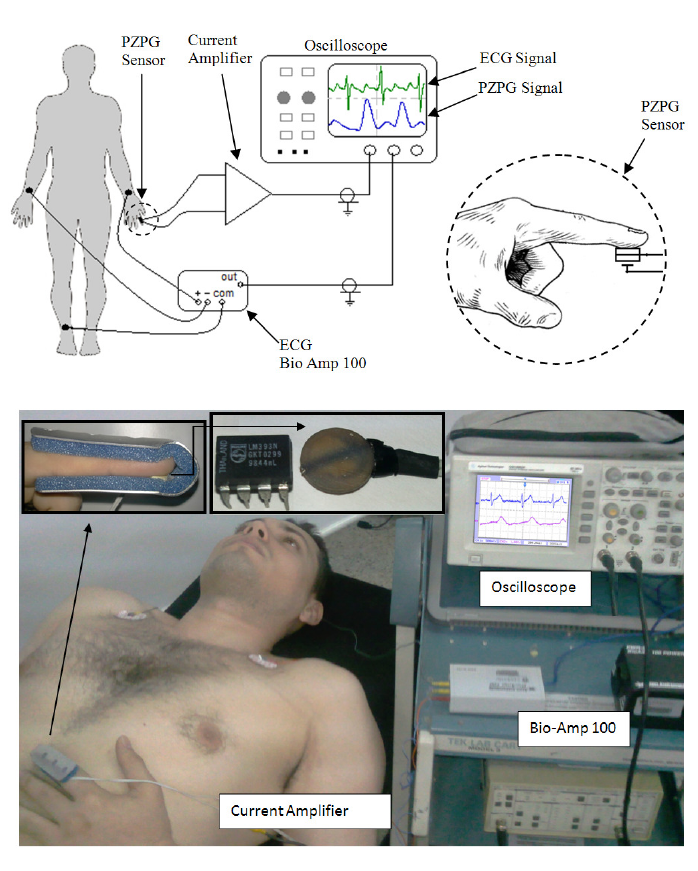
Figure 8. Experimental setup to obtain ECG and PZPG signals from human beings, left: schematic setup, right: real setup.